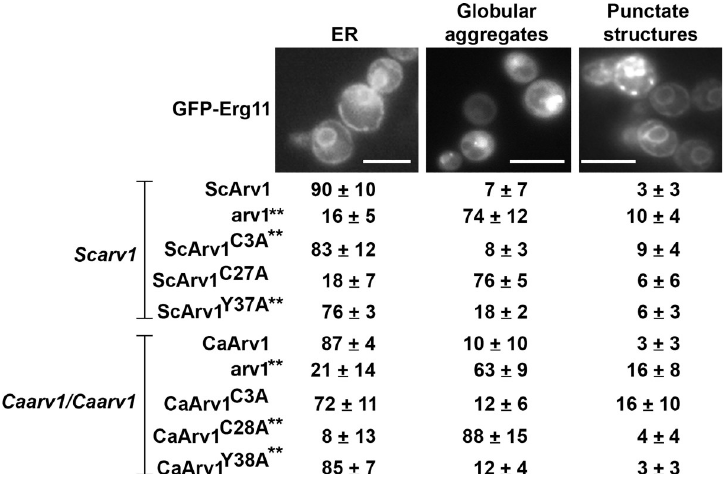
Fig 11. ScArv1 and CaArv1 are required for proper ER localization of GFP-Erg11. GFP-ScErg11 and GFP-CaErg11 proteins, each driven from the ScGPD promoter, were expressed in Scarv1 and Caarv1/Caarv1 cells, respectively. Cells were grown to exponential phase and GFP-Erg11 was visualized by fluorescence microscopy using a Leica RBME fluorescence microscope and 100X optics. 300–500 cells were counted for each strain using double-blind analysis in 5 individual experiments. The values represent the percentage of cells containing the designated structures. The ER localization of Erg11 has been reported previously [37]. Asterisk indicates cells that display defects in GFP-Erg11